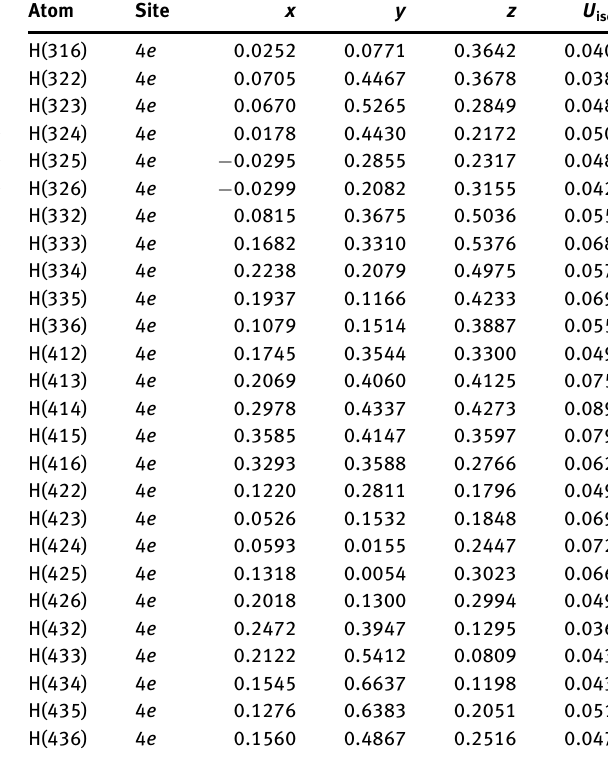
Table 2: Fractional atomic coordinates and isotropic or equivalent isotropic displacement parameters (Å 2